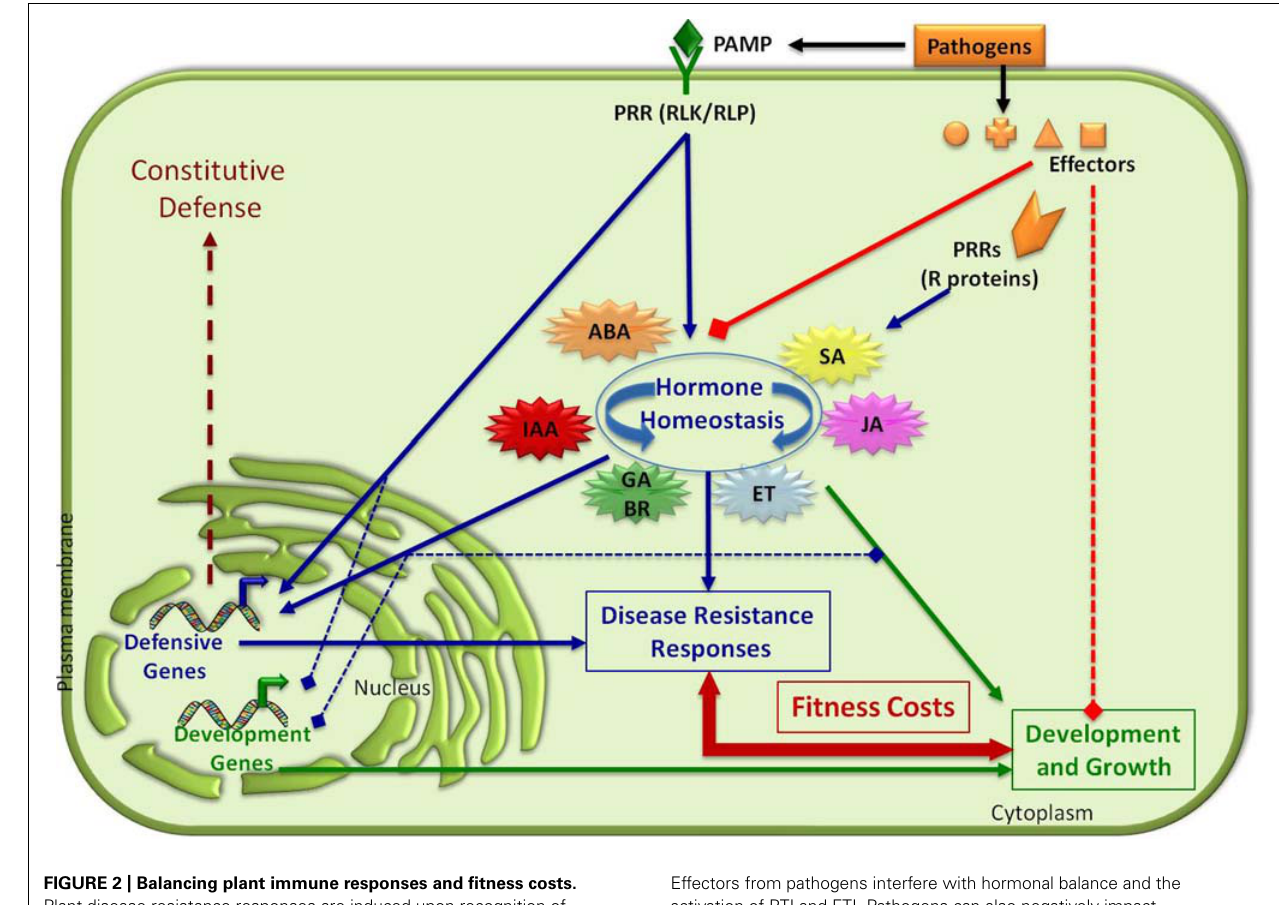
FIGURE 2 | Balancing plant immune responses and fitness costs. Plant disease resistance responses are induced upon recognition of PAMPs/effectors from pathogens and pests by plant PRR proteins.This recognition modulates plant hormonal homeostasis and transcriptional reprograming of defensive genes.The activation of these inducible resistance responses (PTI and/or ETI) negatively regulates the expression of developmental-associated genes impacting on plant fitness costs.